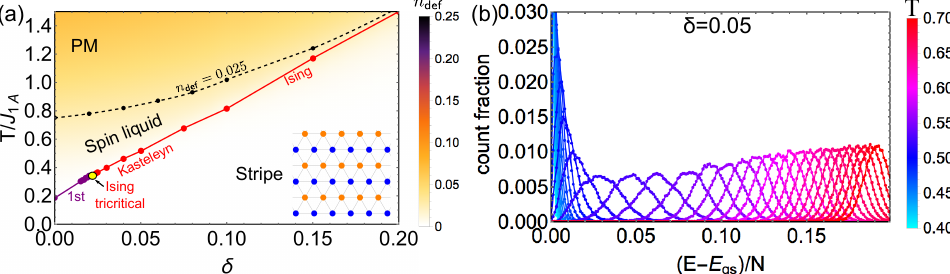
Figure 6: The phase diagram of the dipolar TLIAF as a function of T and δ . (a) The phase transition out of the stripe phase changes from first to second order with increasing anisotropy, δ , via a tricritical point at δ tri = 0.022. Strong correlations are associated with a small defect triangle density, n def , and this is shown by the colour scheme. The crossover from the strong-correlated (spin-liquid) regime to the weakly-correlated paramagnet occurs at approximately n def = 0.025 (i.e. 10% of the saturation value). (b) Energy-histogram analysis, showing a second-order transition for δ = 0.05. Unlike in the case of a first-order transition (see Fig. 3), the energy histogram evolves smoothly across the transition, showing no sign of phase